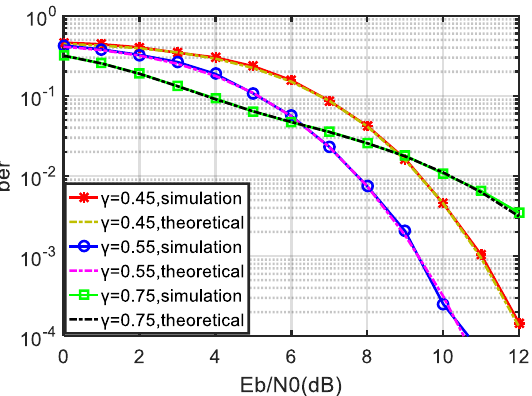
Figure 5. BER performance of noncoherent PPM with different threshold coefficients.